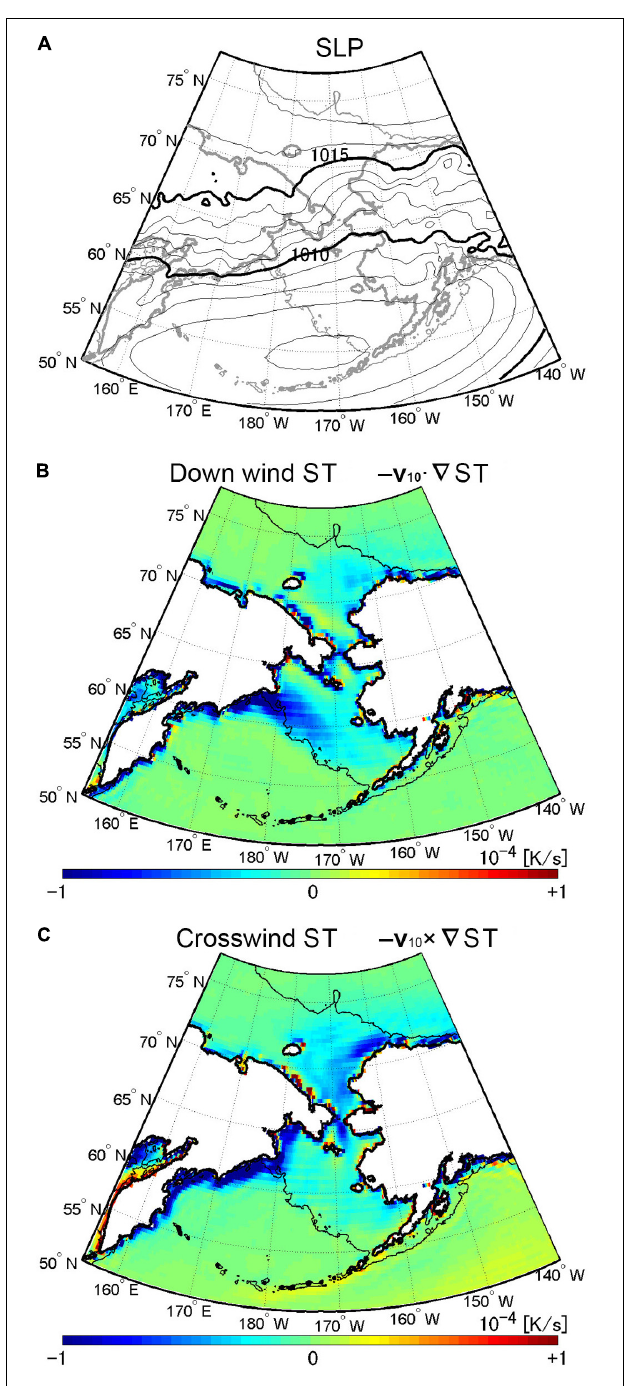
FIGURE 11 | Annual-mean climatology of (A) SLP, (B) sign-reversed downwind ST gradient, and (C) sign-reversed crosswind ST gradient. The intervals indicated by thin and bold contours in (A) are 1 and 5 hPa,